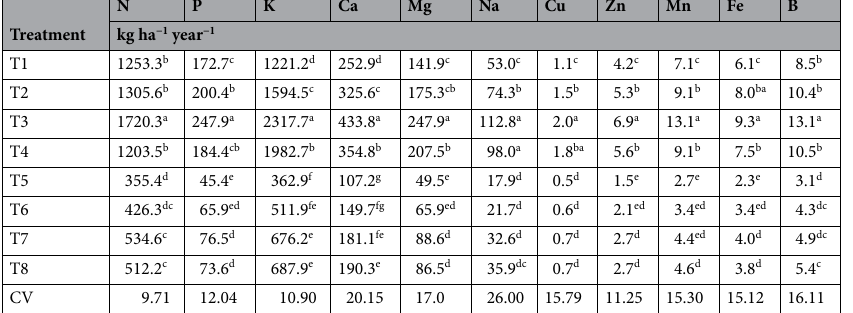
Table 2. Nutrient uptake of King grass kg ha −1 year −1 . CV coefficient of variation. Measures in columns followed by different letters are significantly different (P < 0.05), based on Duncan’s multi-range test.